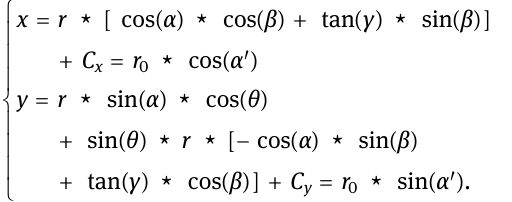
Z - coordinate ( ′) P α z 0 could be calculated by substituting the solved ( α r , ) to the third equation in equation ( 6 ) .